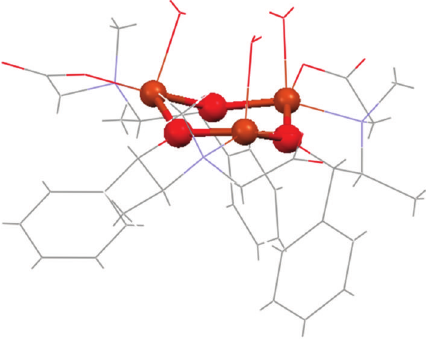
Figure 7: Chair conformation for the [Cu 3 ( S,S (+)cpse) 3 (H 2 O) 3 ] ⋅ 8H 2 O